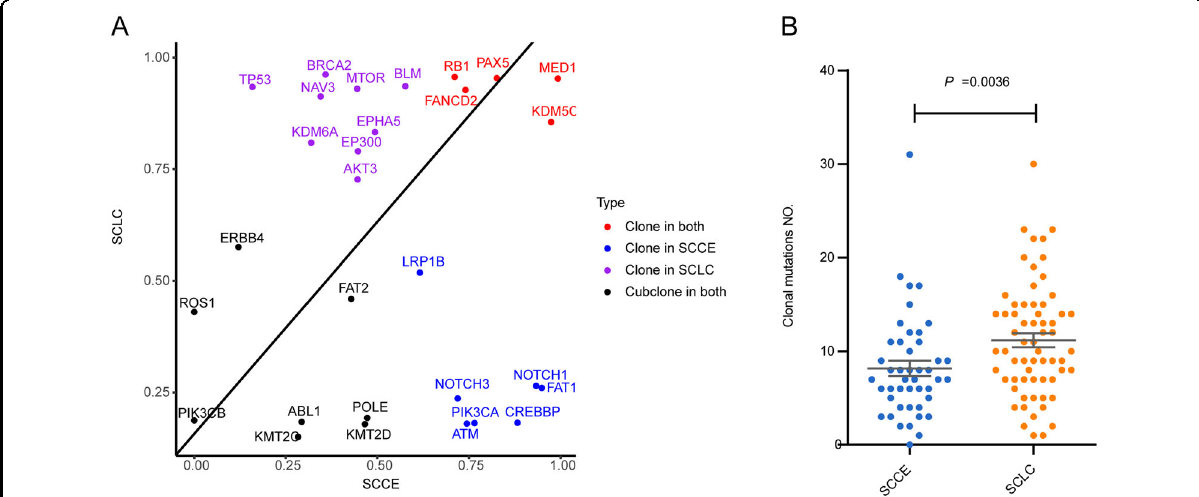
Fig. 3 Clonal and subclonal driver mutations in SCCE and SCLC. A Clonal and subclonal driver gene in SCCE ( x -axis) and SCLC ( y -axis), clonality of genes was identi fi ed using PureCN, and presented with different colors; B the total number of clonal mutations differed between two cancers, and presented lower in SCCE, compared with SCLC (median, 7 v.s. 10 mutations, Mann − Whitney test, p =